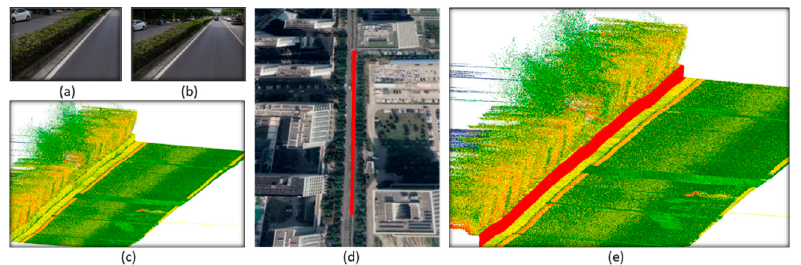
Figure 14. Extraction results of the vegetation covering the curbs. ( a , b ) Two detail views of study sites; ( c ) Original point cloud; ( d ) Street-level imagery of the studied area overlapped by segmented curbs; ( e ) The result of curb extraction by proposed method.